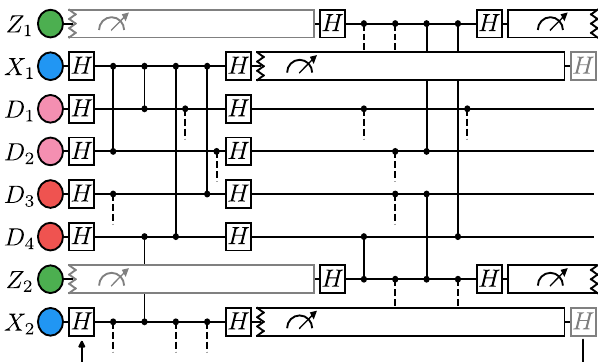
Fig. 8 The quantum circuit for a single QEC cycle employed in simulation. The unit-cell scheduling is de fi ned in ref. 46 . The qubit labels and frequencies correspond to the lattice arrangement shown in Fig. 2. Gray elements correspond to operations belonging to the previous or the following QEC cycle. The X -type parity checks are performed at the start of the cycle, while the Z -type parity checks are executed immediately after the Z -type stabilizer measurements from the previous cycle are completed. The duration of each operation is given in Table 1. The arrow at the bottom indicates the repetition of QEC